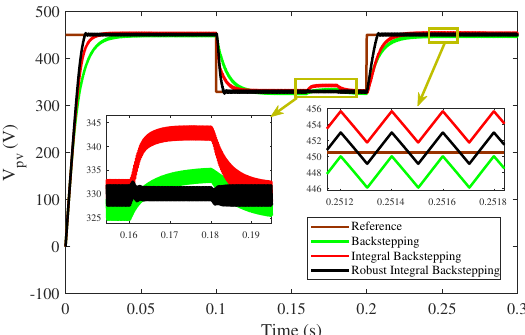
Figure 20. PV array voltage with multiple uncertainties under varying temperature and irradiance.